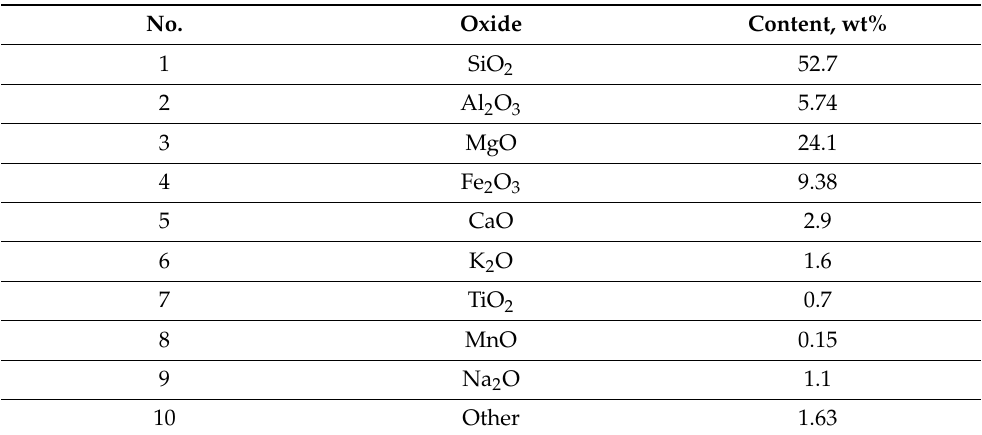
Table 2. Oxide composition of sludge.